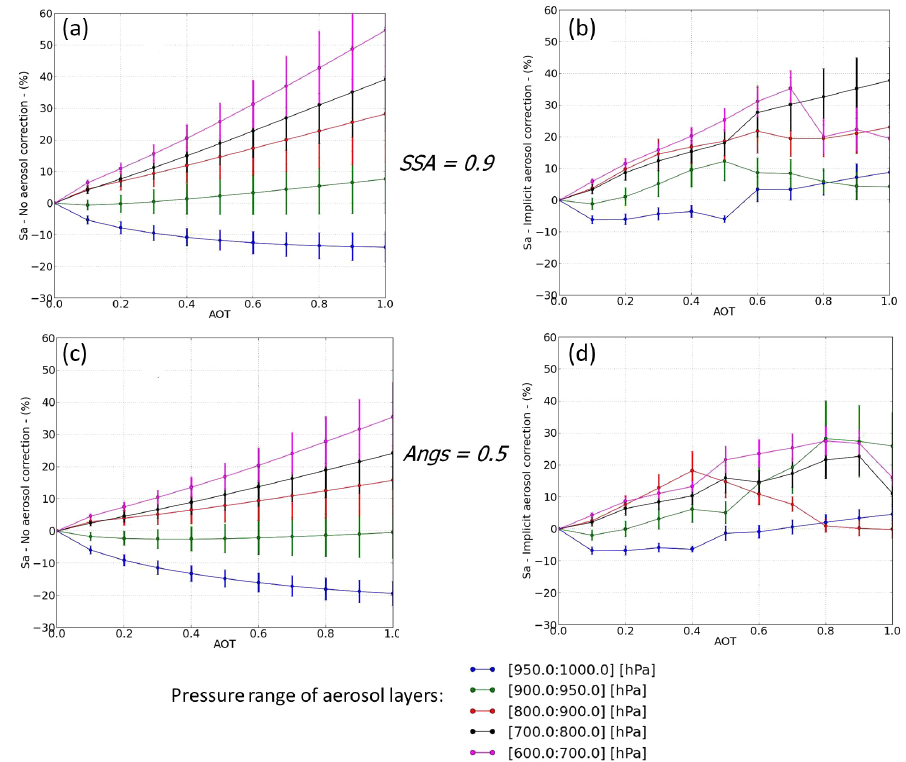
Figure 16. Similar to Fig. 14 but with different aerosol SSA and Ångström coefficient values: (a) S A assuming no aerosol correction, SSA = 0.9, (b) S A assuming implicit aerosol correction through the OMI cloud retrieval algorithm, SSA = 0.9, (c) S A assuming no aerosol correction is applied, Ångström coefficient = 0.5, (d) S A assuming implicit aerosol correction through the OMI cloud retrieval algorithm, Ångström coefficient =